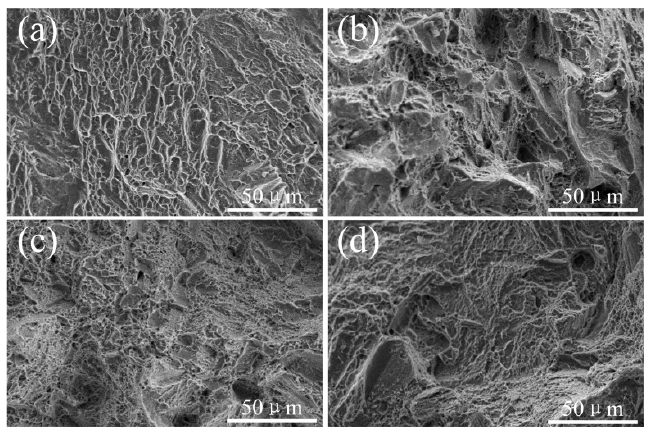
Figure 12. Micro-fractography of Ti6Al4V-xEr casting alloys: ( a ) x = 0; ( b ) x = 0.2; ( c ) x = 0.4; ( d ) x = 0.6 wt %.